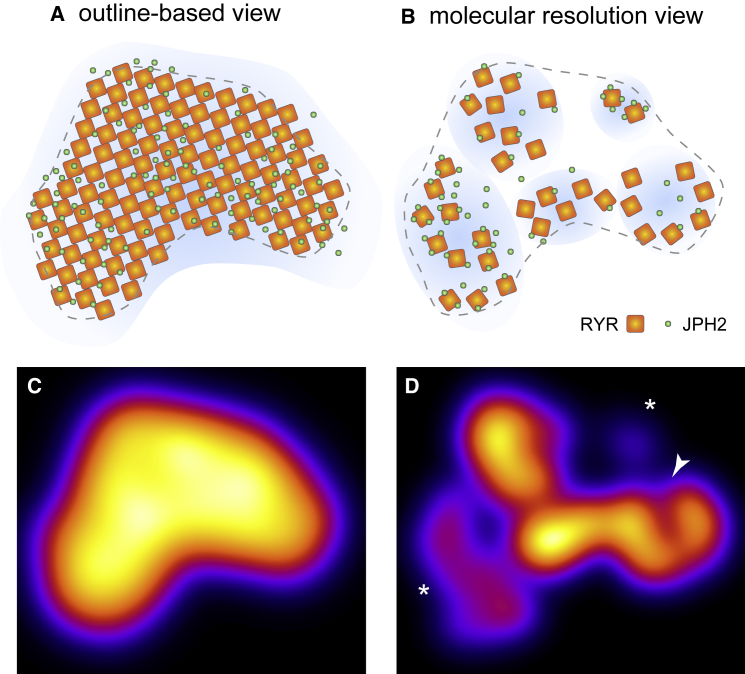
Schematic Comparison of Outline-Based and Molecular Scale Views of RyR Clusters(A and B) Schematic comparison of the outline-based view of RyR clusters (A) and the molecular-scale maps (B). The latter account for variable arrangements of RyRs, gaps in arrays and differential co-clustering with JPH2.(C) Schematic activation probability maps of clusters highlight uniform cluster activation probability in the regularly filled array compared to the heterogeneous activation of clusters (asterisks) and expected intra-nanodomain Ca2+ gradients (arrow) in the molecular-scale model.